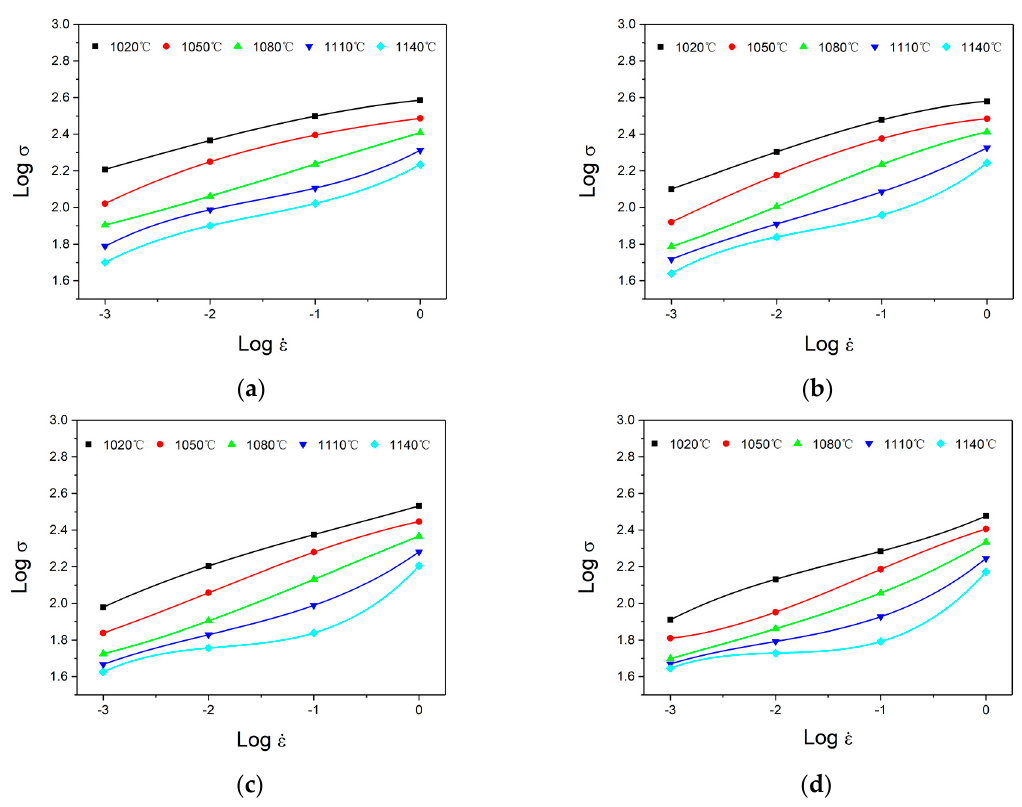
Figure 9. Relationships between stress and strain rate in log scale of the PM/Wrought dual superalloy at different deformation temperatures as true strains: ( a ) 0.1; ( b ) 0.3; ( c ) 0.5; ( d ) 0.69.